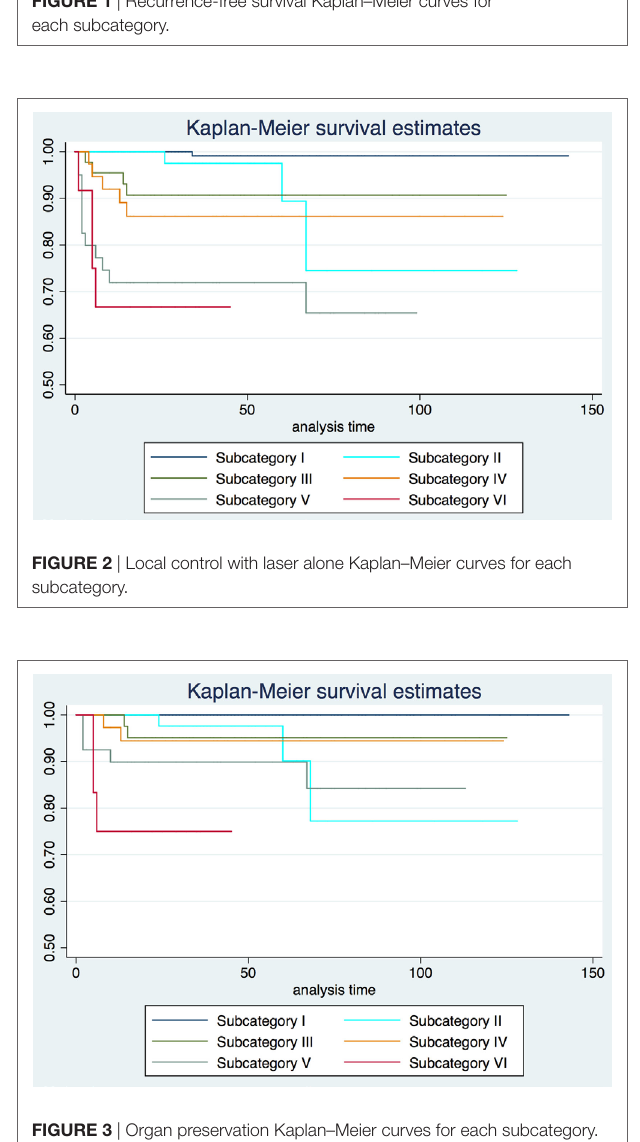
FigUre 3 | Organ preservation Kaplan–Meier curves for each subcategory.